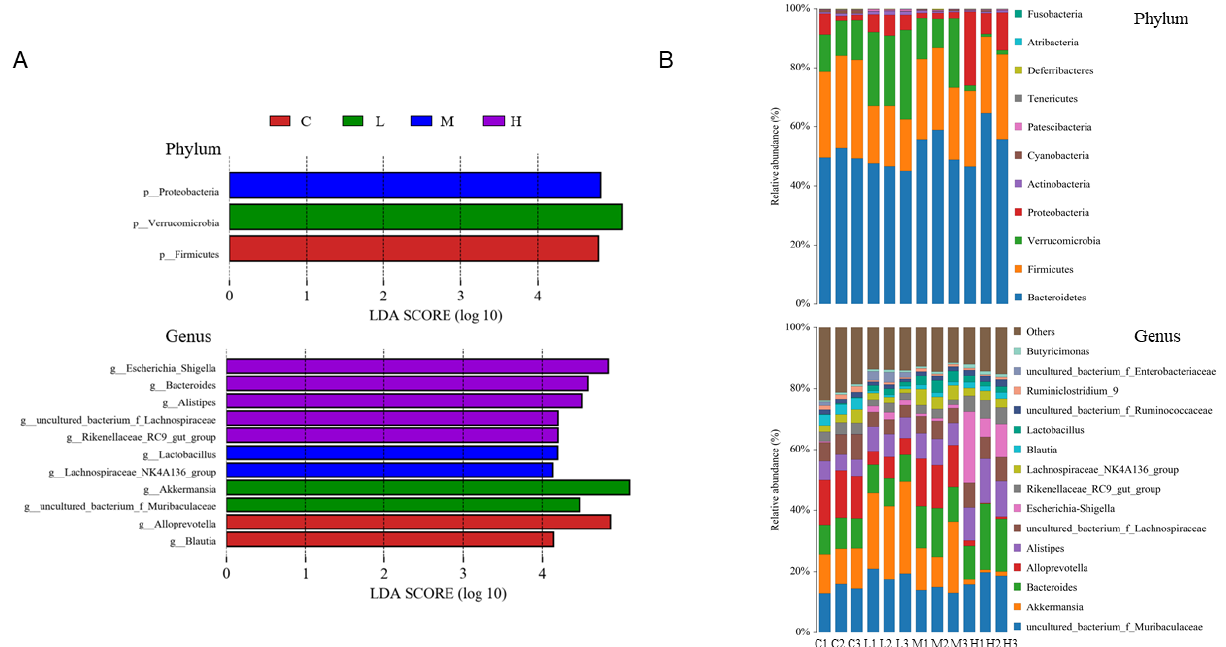
Figure 4. The dominant composition of gut microbiota after FRJ treatments. ( A ) Linear discriminant analysis (LDA) effect size (LEfSe) analyses at phylum and genus level (LDA score > 4.0). ( B ) Relative abundance of microbiota at phylum and genus level. C: mice fed with standard diet; L: mice fed with 3% (wt:wt) FRJ supplementation; M: mice fed with 6% (wt:wt) FRJ supplementation; H: mice fed with 9% (wt:wt) FRJ supplementation. Each number of the samples represents one replicate.